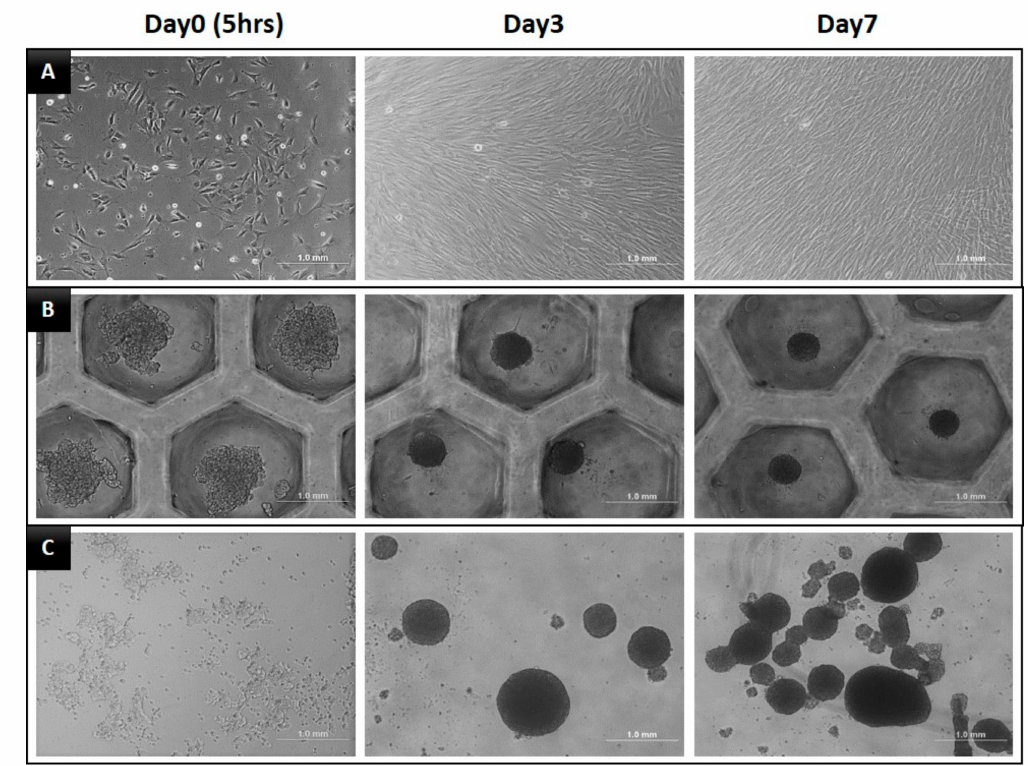
Figure 2. Morphology of DPSCs during seven days of incubation in three di ff erent culture plates. ( A ) 2D group, with plain culture plate, ( B ) SF group, with U-bottom plate, and ( C ) ULA group, with flat-bottom ultra-low attachment